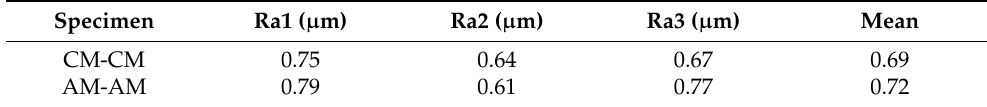
Table 9. Roughness measurement after polishing.